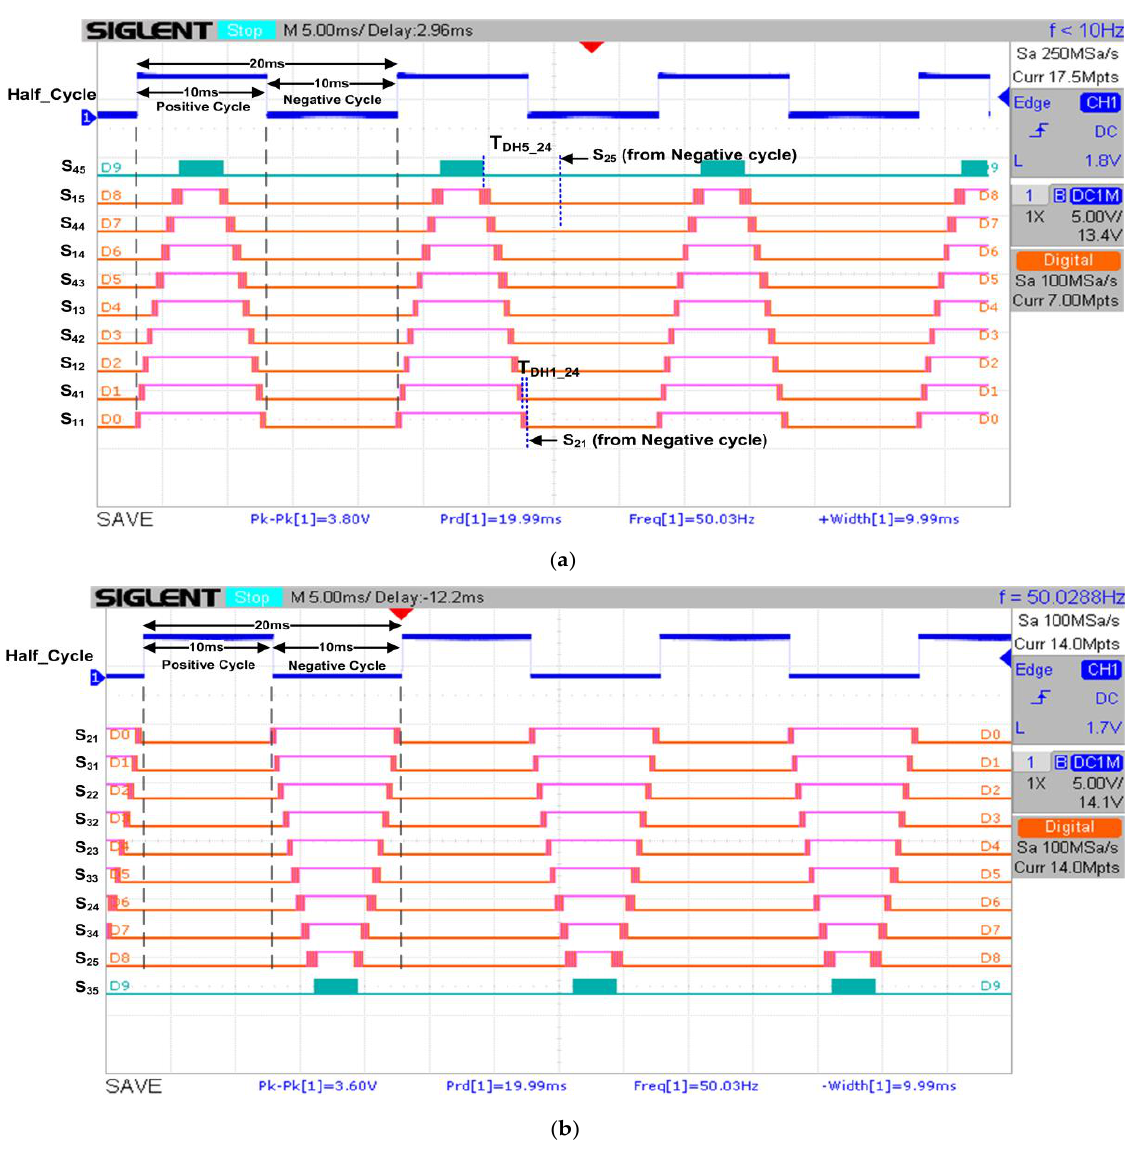
Figure 22. Hardware measurement of the SPWM digital switching controller’s output gating pulses: ( a ) Output gating pulses for positive cycle (“S 45 ” to “S 11 ”). ( b ) Output gating pulses for negative cycle (“S 21 ” to “S 35